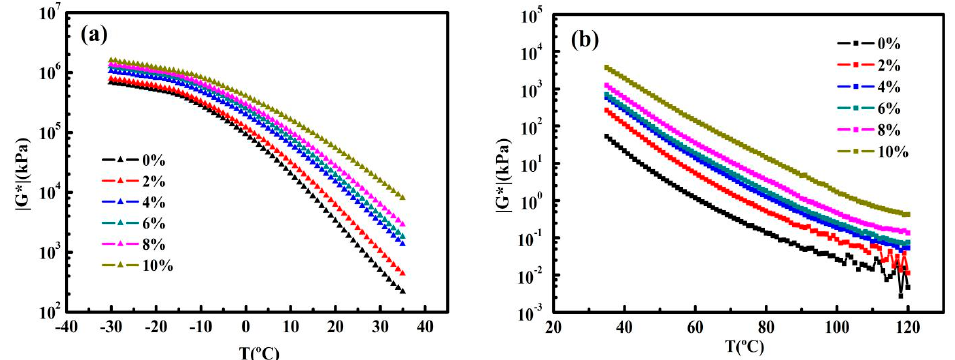
Figure 7. ( a ) Temperature sweeps results of control asphalt and GMAs (complex modulus versus temperature) at − 30–35 °C (PP08). ( b ) Temperature sweeps results of control asphalt and GMAs (complex modulus versus temperature) at 35–120 °C (PP25).